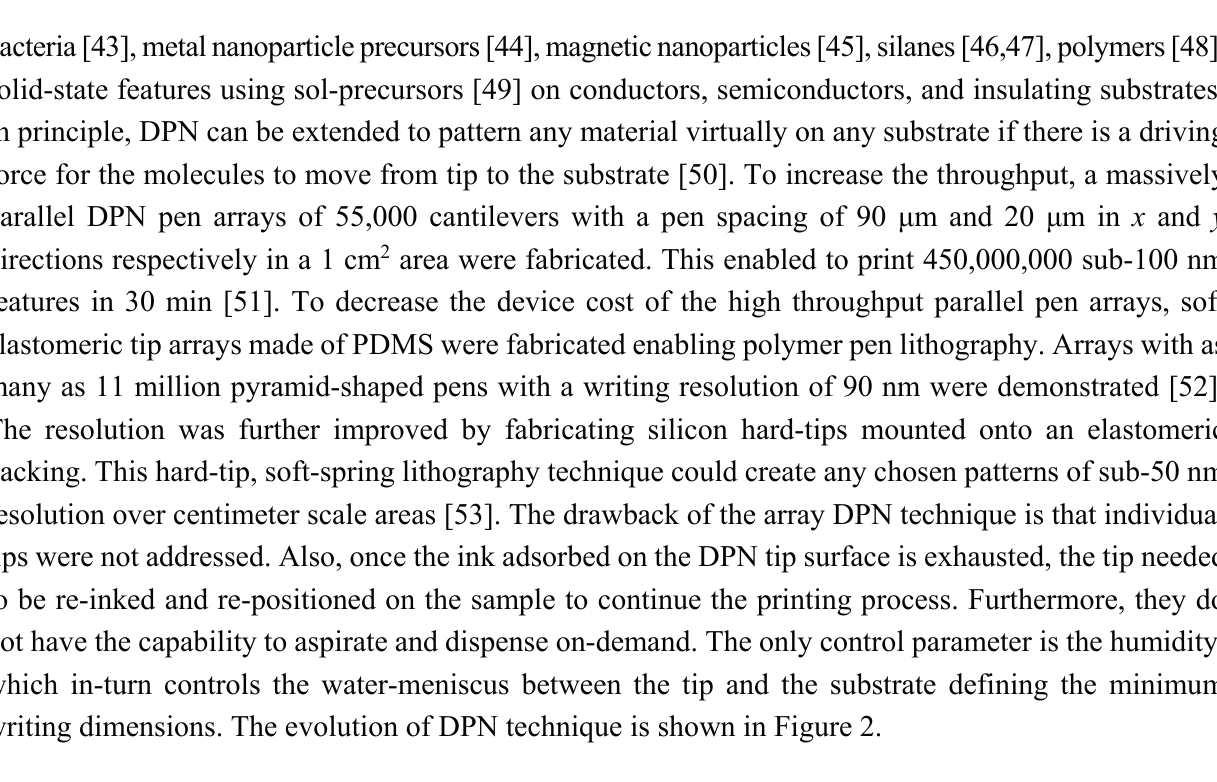
Figure 2. The evolution of Dip Pen Nanolithography (DPN). Reprinted with permission from